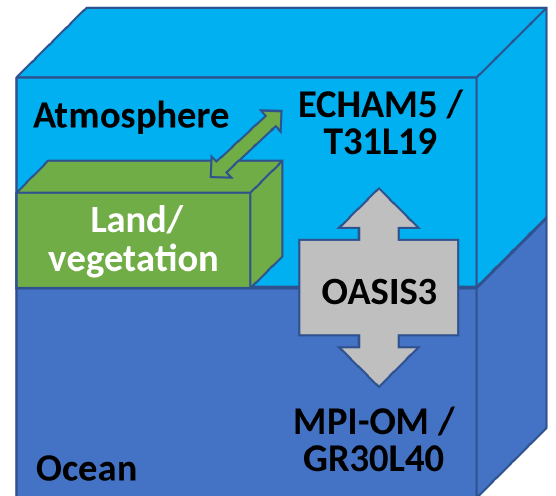
Figure 1. Schematic of the Community Earth System Models (COSMOS) toolbox that is composed of two model components and a coupler: atmosphere–land–vegetation (ECHAM5/JSBACH) and ocean–sea ice (MPI-OM) are coupled by OASIS3. See text for